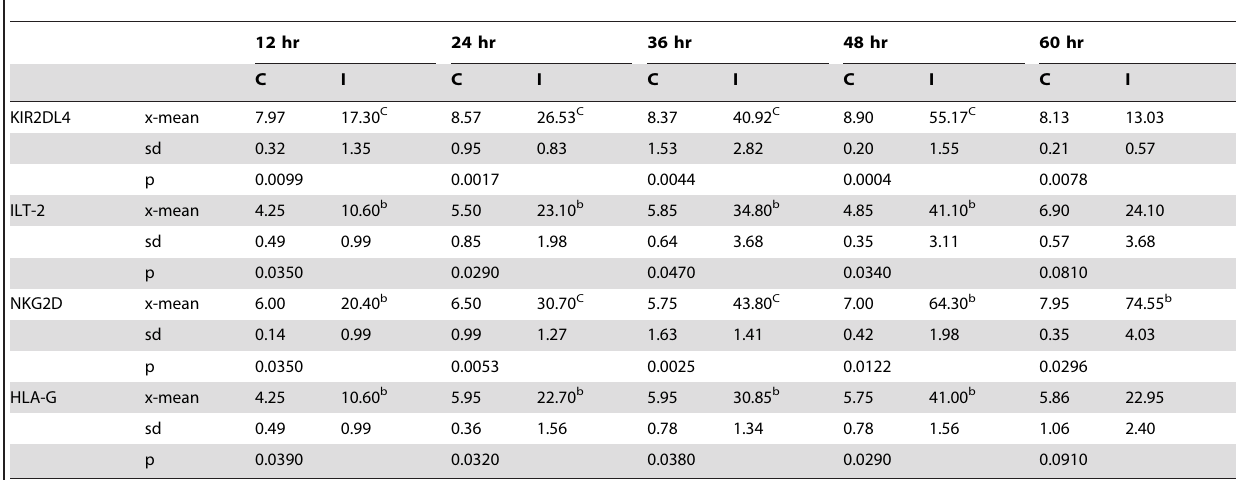
Table 2. Changes in levels of dNK receptors and HLA-G following T. gondii infection. a